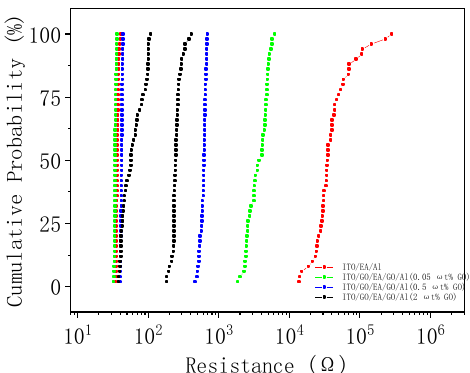
ITO/GO/EA/GO/Al device with a GO concentration of 0.5 ωt% in the GO layers are more uniform than those of the other devices.